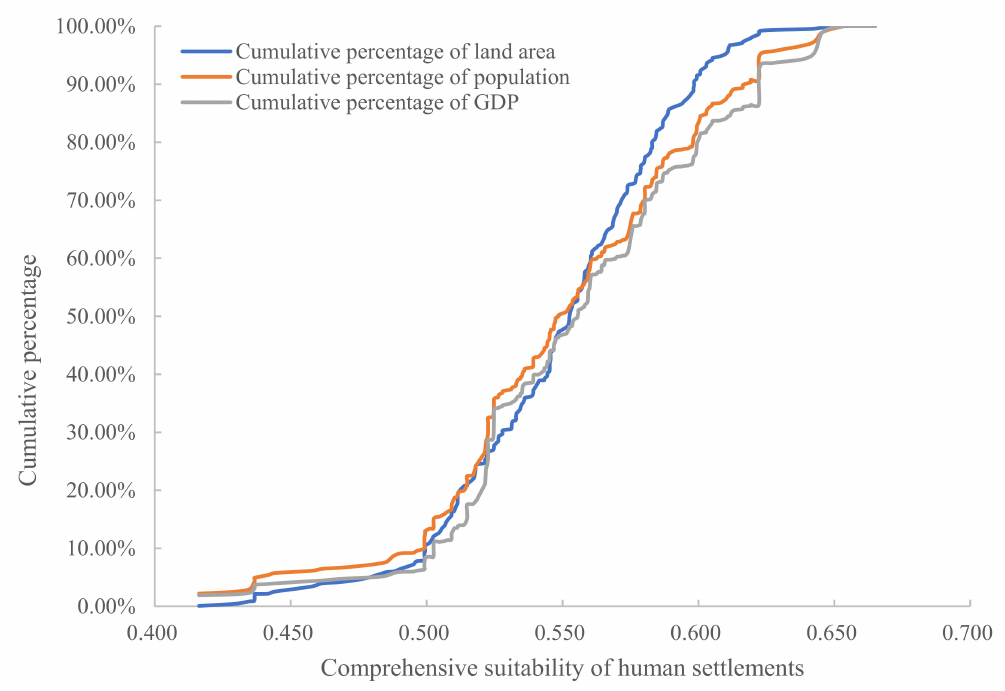
Figure 8. The cumulative percentage of land area, population, and economy in the